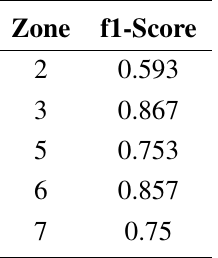
Table 8. f1-score of classification of 5 zones in Building B.